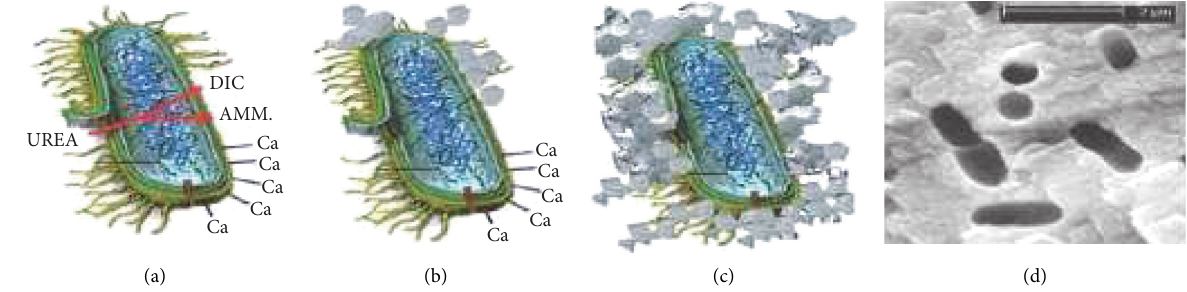
Figure 3: Key roles of pH and calcium metabolism in microbial carbonate precipitation